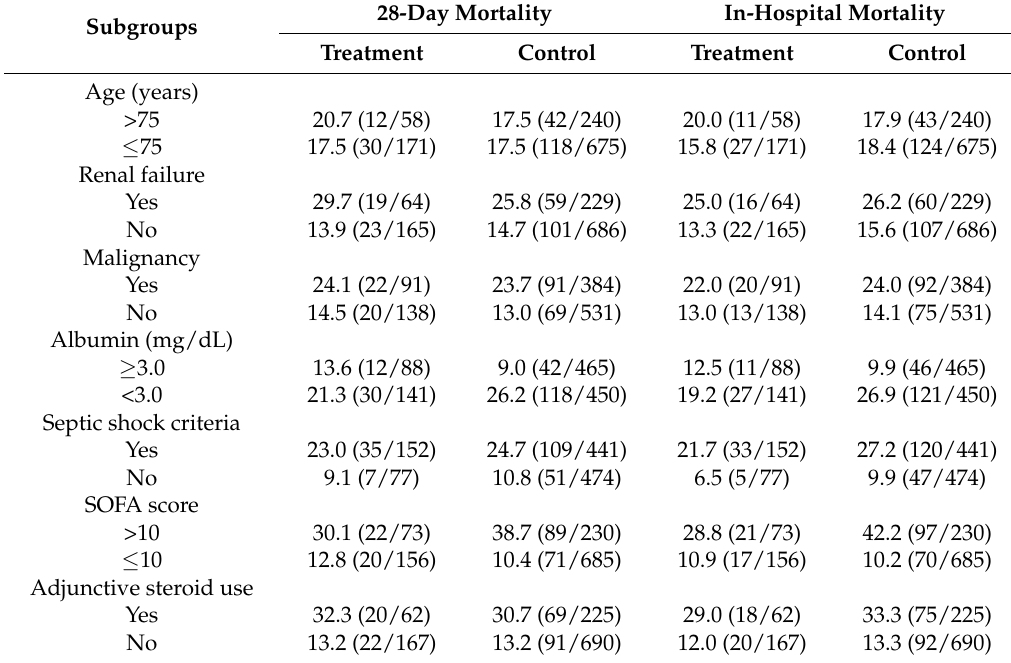
Table 4. Crude 28-day and in-hospital